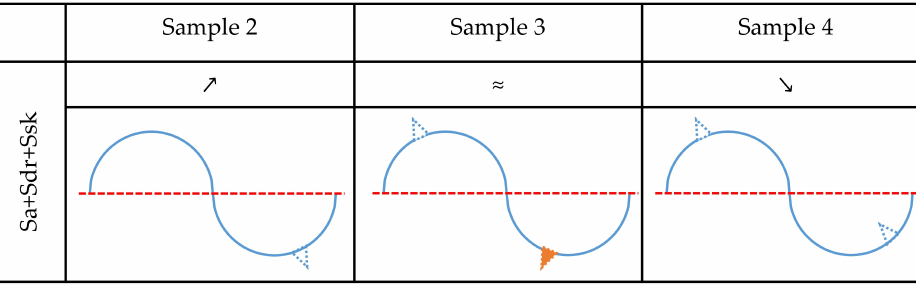
13Figure 13. Dominant corrosion effects that correlate with changes in parameters Sa, Sdr, and Ssk. Figure The empty blue triangle represents material loss while the orange filled triangle represents material gain. Results of paired t test are symbolically represented by symbols ≈ , (cid:37) , (cid:38) . These symbols represent insignificant difference, significant increase, and significant decrease in specific parameters,